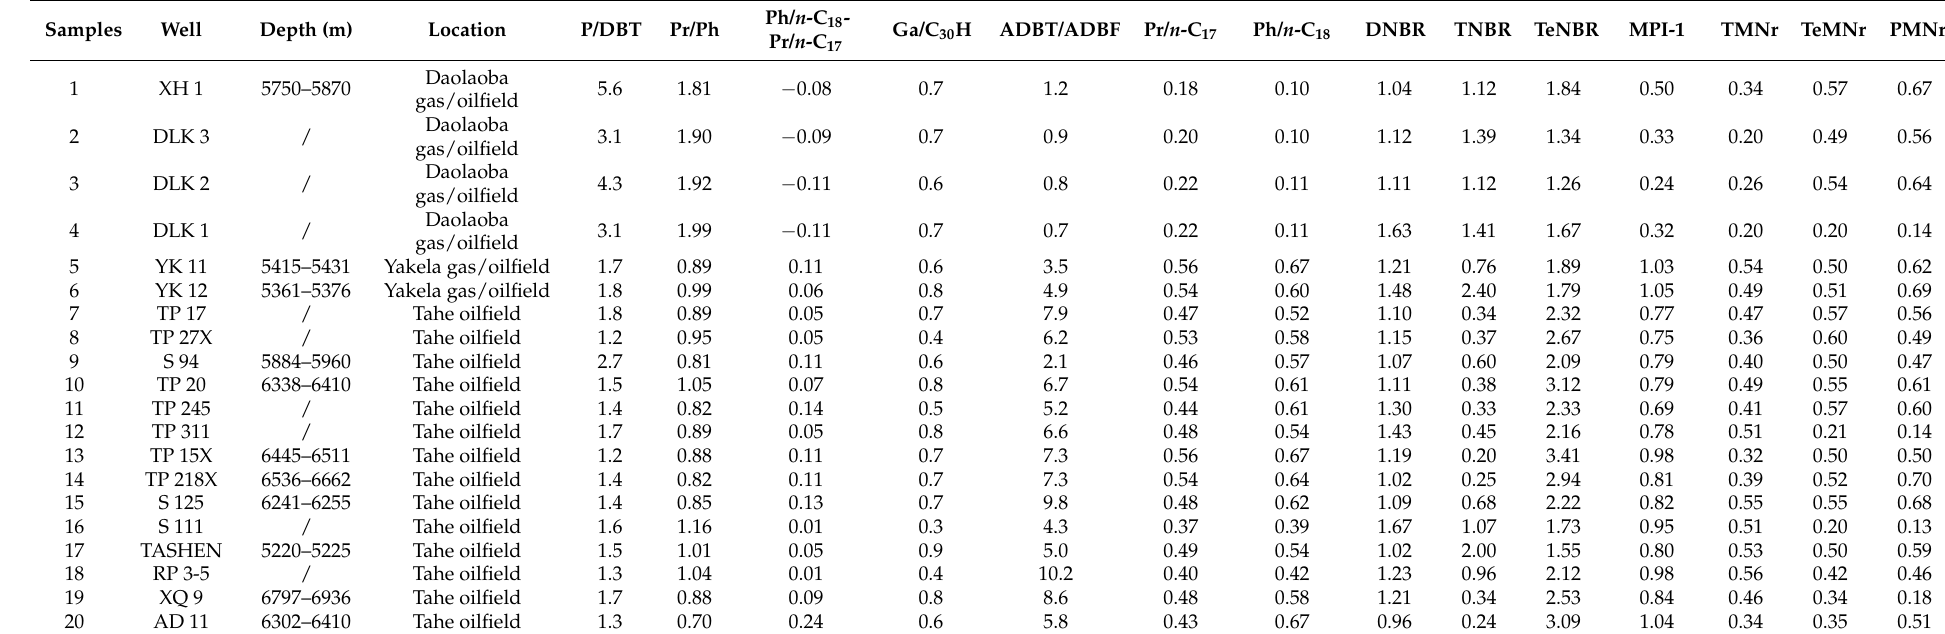
Table 1. List of crude oils and related geochemical